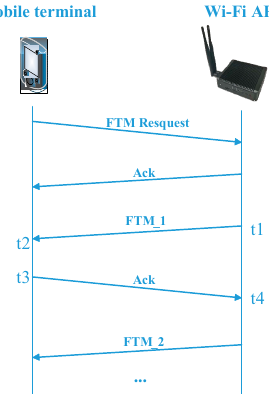
Figure 1. Procedure of Wi-Fi Fine Time Measurement ( FTM)